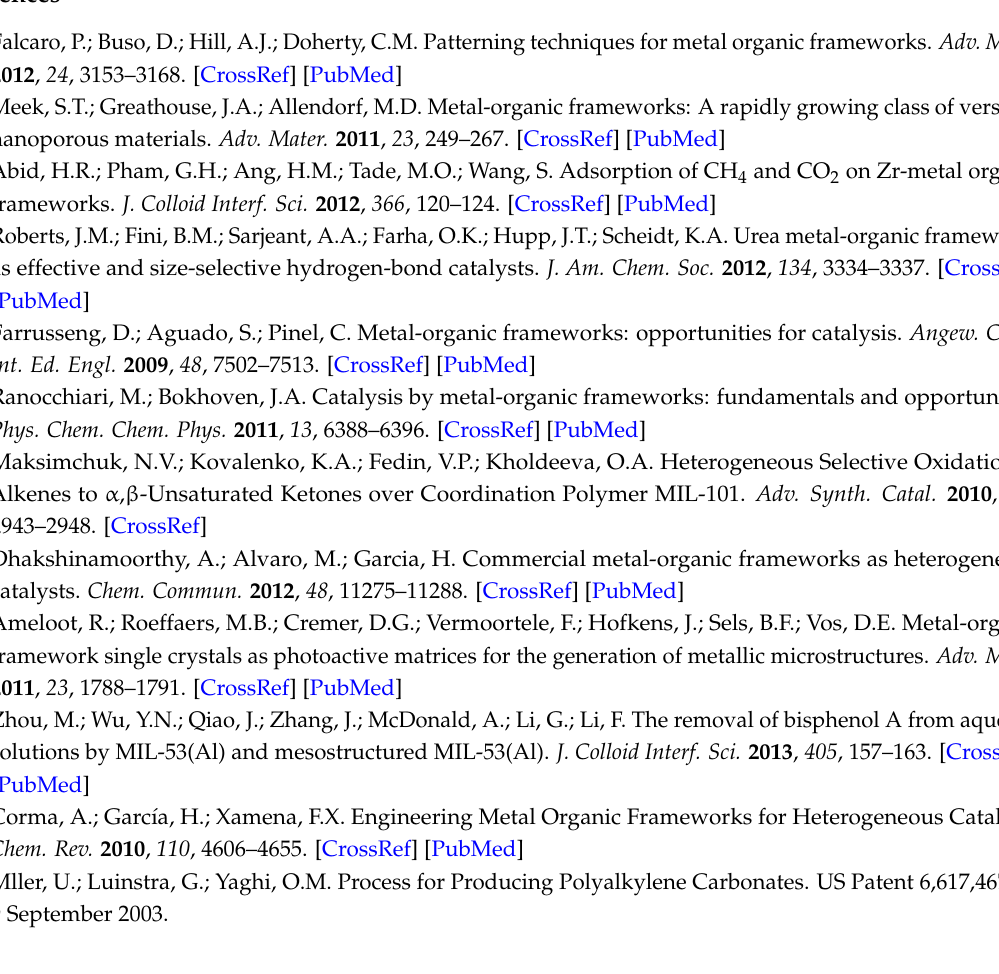
Figure S1: (a) SEM image of pure ZIF-8 particles; (b) TEM image of pure ZIF-8 particles, Figure S2: Powder XRD pattern for ZIF-8 nanoparticles before the reaction, Figure S3: Nitrogen sorption isotherms of as-synthesized ZIF-8 nanocrystals at 77 K. Black and red data correspond to the adsorption and desorption branches, respectively, Figure S4: XRD patterns of pure ZIF-8 (a), ZIF-8 treated by o -xylene before the polymerization reaction (b), ZIF-8 treated by o-xylene after the polymerization reaction (c), Figure S5: SEM images of the polymerization products of C 18 H 37 SiH 3 by 0.01 g ZIF-8 at (a) 20 ◦ C, 4 h; (b) 30 ◦ C, 4 h; (c) 30 ◦ C, 5 min; (d) 30 ◦ C, 12 h, Figure S6: SEM images of the polymerization products of C 18 H 37 SiH 3 at 90 ◦ C for 4 h (a) 0.01 g ZIF-8; (b) 0.02 g ZIF-8; (c) 0.03 g ZIF-8, Figure S7: TEM images of the polymerization products of C 18 H 37 SiH 3 by ZIF-8 at (a) 30 ◦ C, (b) 90 ◦ C, Figure S8: SEM images of the reaction products by using Zn(NO 3 ) 2 at 30 ◦ C for 4 h (a,b); at 90 ◦ C for 4 h (c,d), Figure S9: The profiles of water droplets on (a) ZIF-8, (b) and the polymerization products of C 18 H 37 SiH 3 by